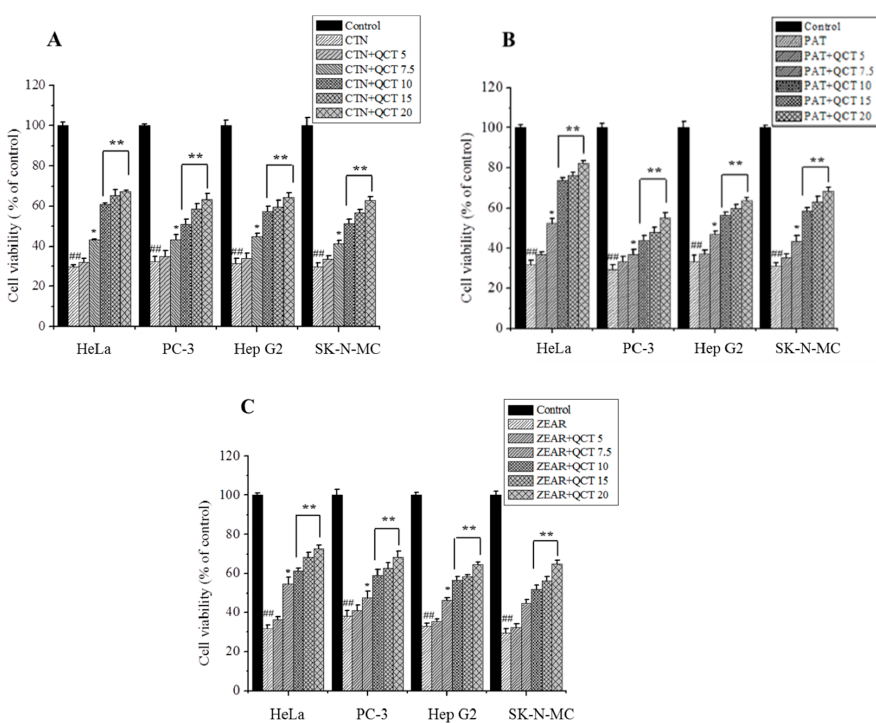
Figure 3. The protective effect of QCT against MTX-induced cell death. ( A ) Cell viability on HeLa, PC-3, Hep G2, and SK-N-MC cells when pretreated with QCT and post-treated with various MTXs, such as ( A ) CTN, ( B ) PAT, and ( C ) ZEAR. Values were represented as mean ± SD. ## p < 0.01 as compared with the control group; * p < 0.05; ** p < 0.01 as compared with the MTX alone group.